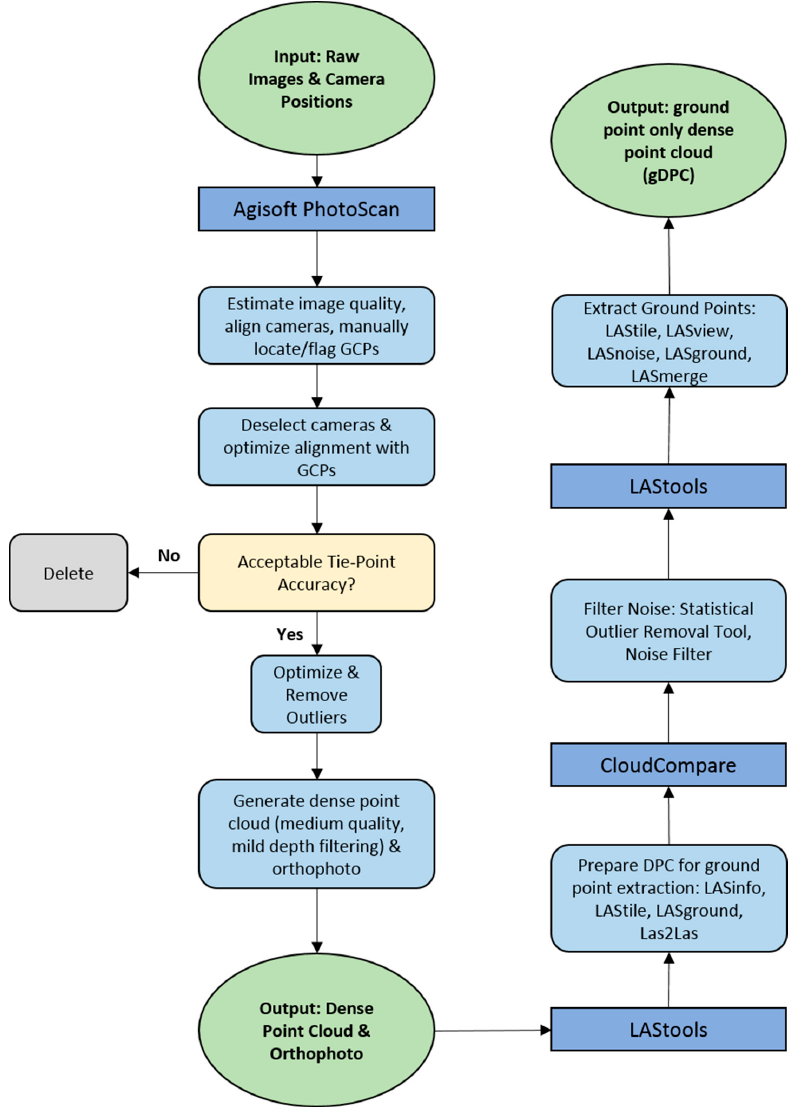
Figure 3. Photogrammetric and point-cloud management software workflow illustrating the process of using UAV flight data to generate secondary (DPC and orthomosaic) and tertiary products (ground dense point cloud (gDPC)) used in this research.